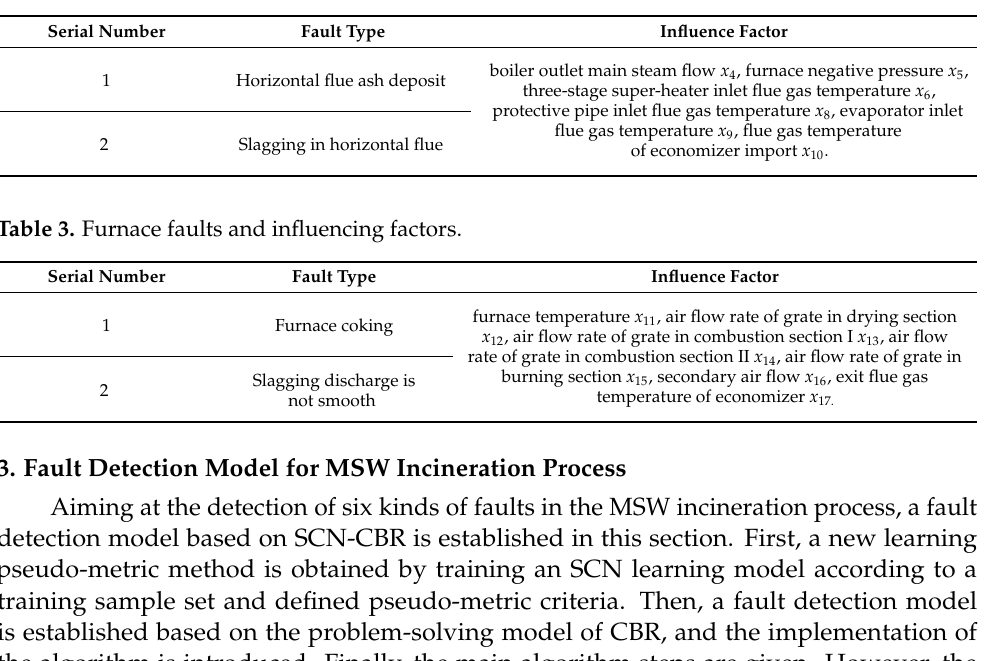
Table 2. Faults and influencing factors of horizontal flue gas channel.